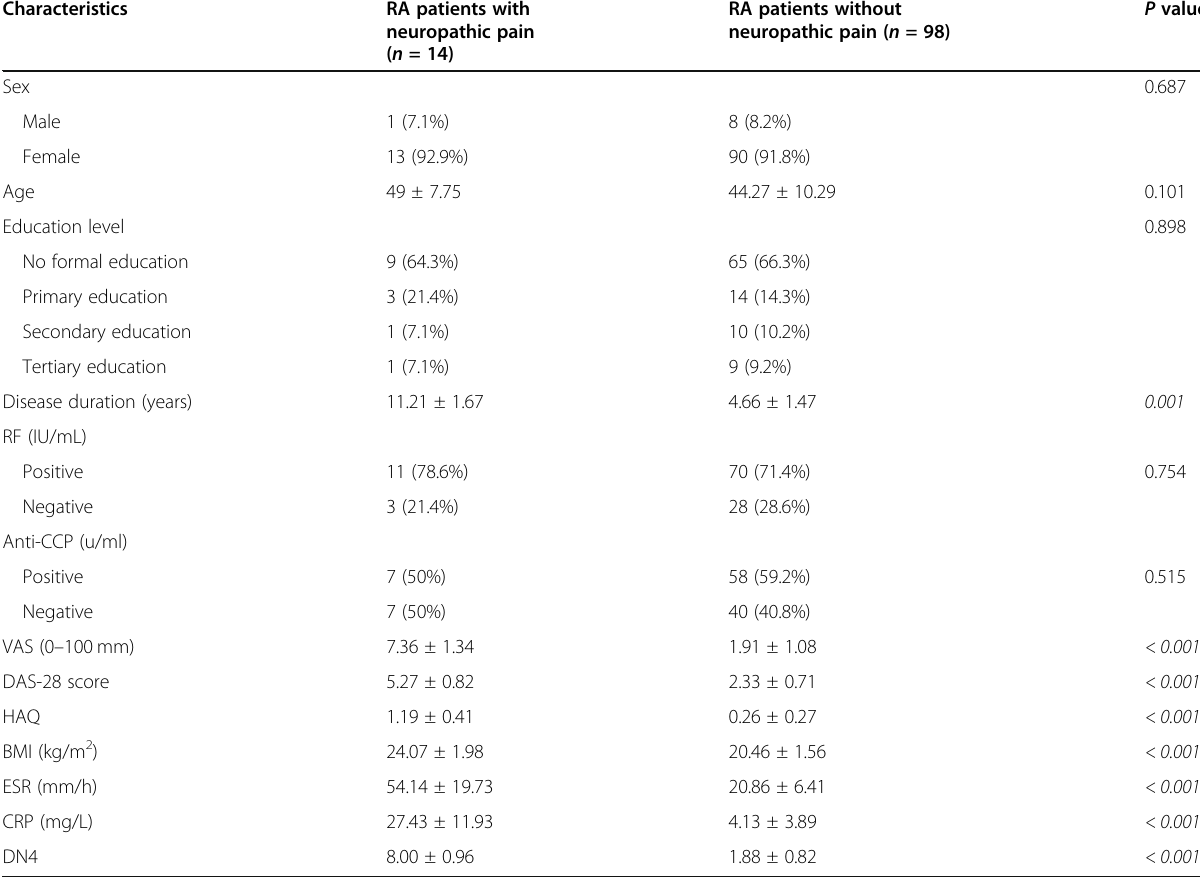
Table 1 Comparison between RA patients with neuropathic pain and those without neuropathic pain